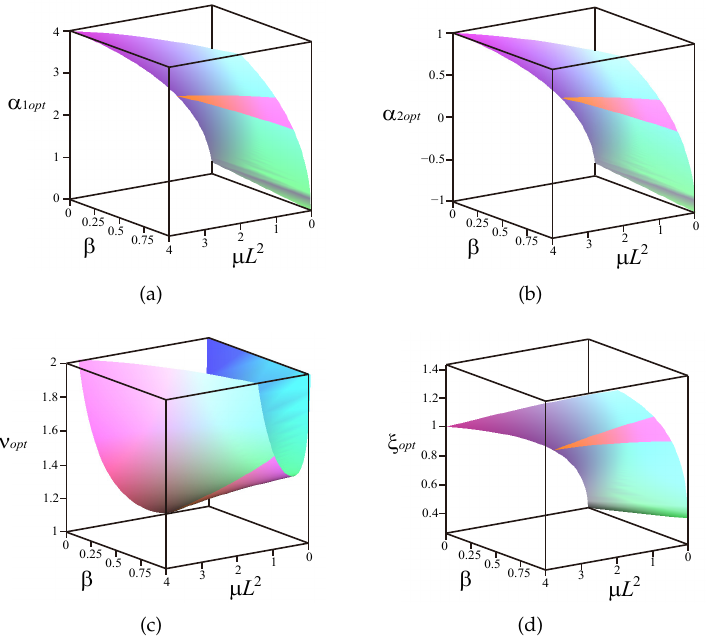
Figure 6. The relationship between optimal parameters and system parameters when α 1 > 0: ( a ) α 1 opt . ( b ) α 2 opt . ( c ) ν opt . ( d ) ξ opt .